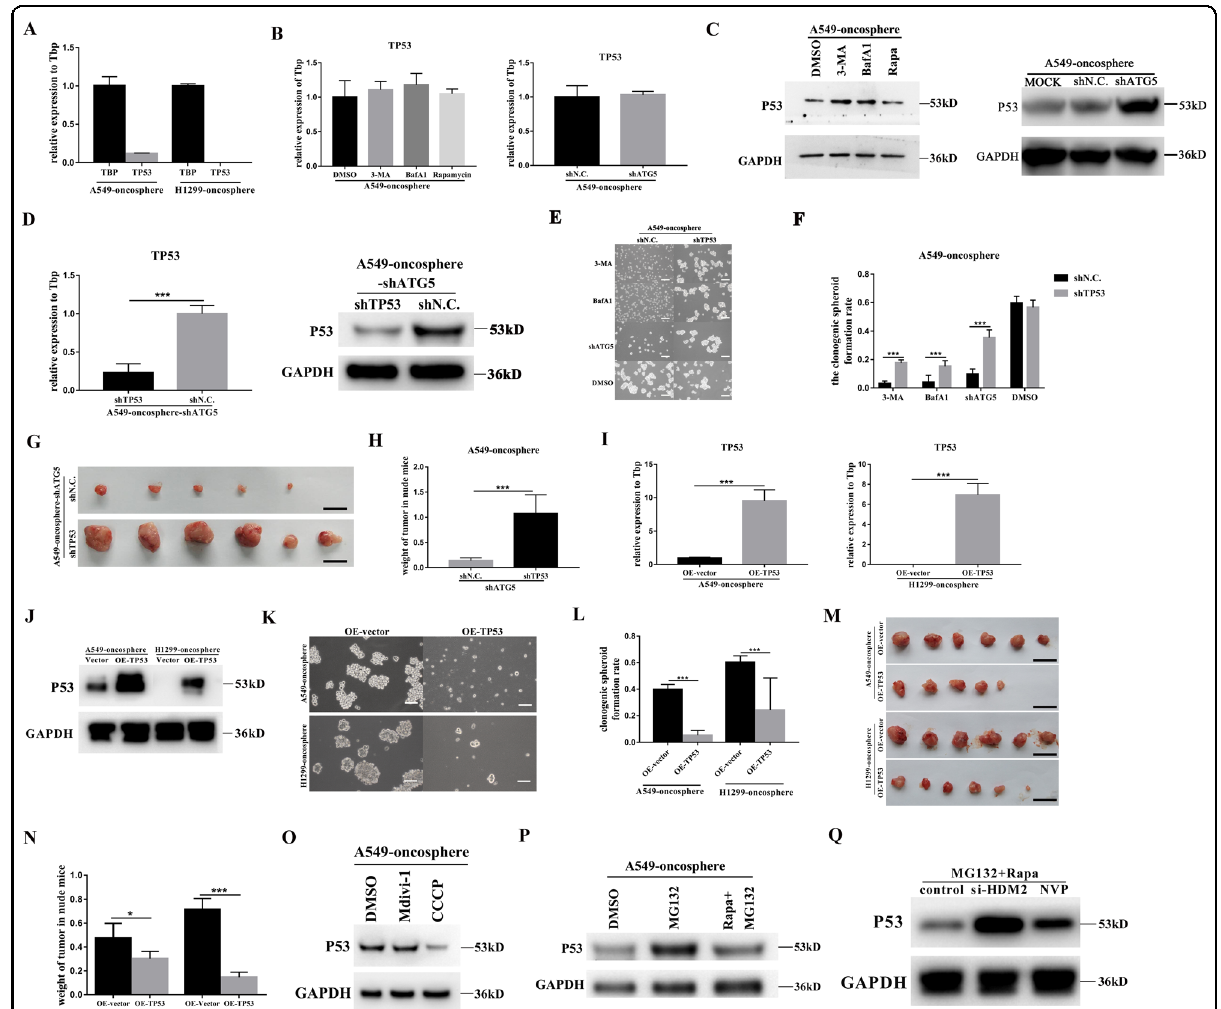
Fig. 4 Augmentation of the stemness of human lung CSCs by autophagy is dependent on degradation of ubiquitinated p53. A Analysis of mRNA expression of TP53 in A549-oncosphere, and H1299-oncosphere; Tbp was used as a reference control. B Analysis of mRNA expression ( B Tbp was used as a reference control) and protein level of p53 ( C GAPDH was used as a reference control) in A549-oncosphere treated with DMSO, 3-MA, BafA1, rapa, and knockdown of ATG5. D Analysis of mRNA expression and protein levels of p53 in A549-oncosphere-shATG5 after siRNA knockdown of TP53 (A549-oncosphere-shATG5-shTP53); Tbp and GAPDH were used as a reference controls, *** p < 0.01. Colony formation assay ( E bar = 120 µm) and single-cell cloning assay ( F *** p < 0.01) using A549-oncosphere-shATG5 and H1299-oncosphere-shATG5 in which ATG5 cells treated with 3-MA, BafA1 followed knockdown of TP53, DMSO was the control group . G , H Subcutaneous tumors excised ( G , images; H : tumor weight, p < 0.01) from nude mice receiving A549-oncosphere-shATG5-shTP53, A549-oncosphere-shATG5-shN.C cells. Bar = 1 cm. I , J Analysis of mRNA expression and protein levels of p53 in A549-oncosphere and H1299-oncosphere after overexpression of TP53 (A549-oncosphere-OE-TP53 and H1299-oncosphere- OE-TP53); Tbp and GAPDH were used as reference controls, *** p < 0.01. Colony formation assay ( K bar = 120 µm) and single-cell cloning assay ( L *** p < 0.01.) using A549-oncosphere cells overexpressing TP53 (A549-oncosphere-OE-TP53 and H1299-oncosphere-OE-TP53). M , N Subcutaneous tumors excised ( M , images; N : tumor weight, *** p < 0.01) from nude mice receiving A549-oncosphere cells overexpressing TP53 (A549-oncosphere-OE-TP53 and H1299-oncosphere-OE-TP53). Bar = 1 cm. O , P Analysis of protein levels of p53 in A549-oncosphere treated with DMSO, Mdivi-1, CCCP O , MG132 and MG132 in combination with rapa ( P ) by WB; GAPDH was used as a reference control. Q Analysis of protein level of p53 in A549-oncosphere upon HDM2 silencing (di-HDM2) or NVP, followed by treatment with MG132 in combination with rapa; GAPDH was used as a reference control. The concentration of 3-MA, BafA1, rapa, Mdivi-1, CCCP, MG132, and NVP was 3 mM, 100 nM, 5 µM, 75 µM, 50 µM, 40 µM, and 300 nM, respectively, and cells used in this fi gure were treated for 24 and LAMP1(purple) by IF in the presence of BafA1 (Fig. S2F). Therefore, autophagy was one way of degrading cytosolic ubiquitinated p53, thus allowing autophagy As previously mentioned, Zeb1, a downstream effector of augmentation of the stemness of lung CSCs. TP53 could regulate the stemness of the mouse lung